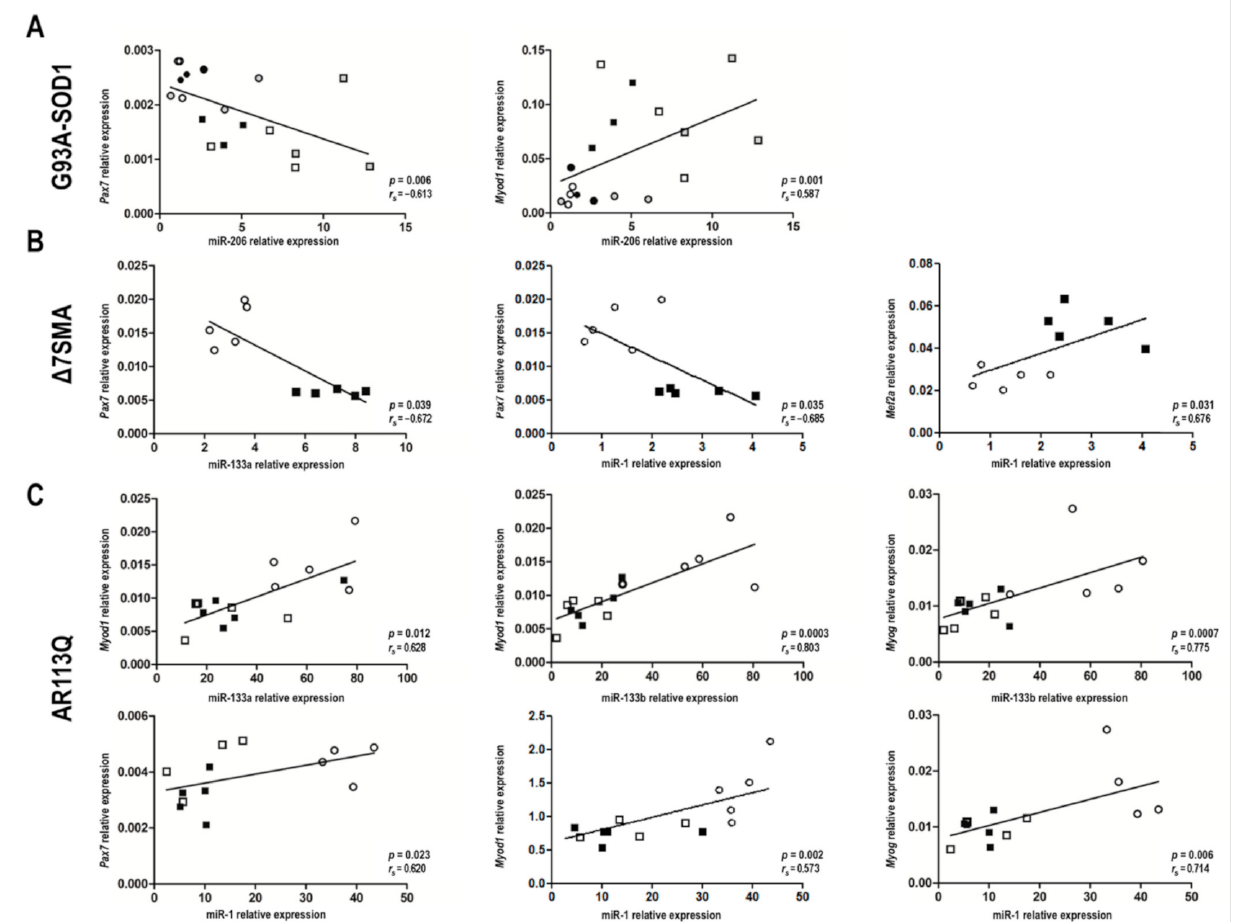
Figure 5. MyomiR/mRNA correlation analysis in G93A-SOD1, ∆ 7SMA, and AR113Q during disease progression. Negative and positive correlations ( p < 0.05) estimated by Spearman’s correlation test between myomiR and mRNA levels of Pax7 , Myod1 , Myog , and Mef2a in muscle tissue of: ( A ) G93A-SOD1 at weeks 7 ( • ), 8 (